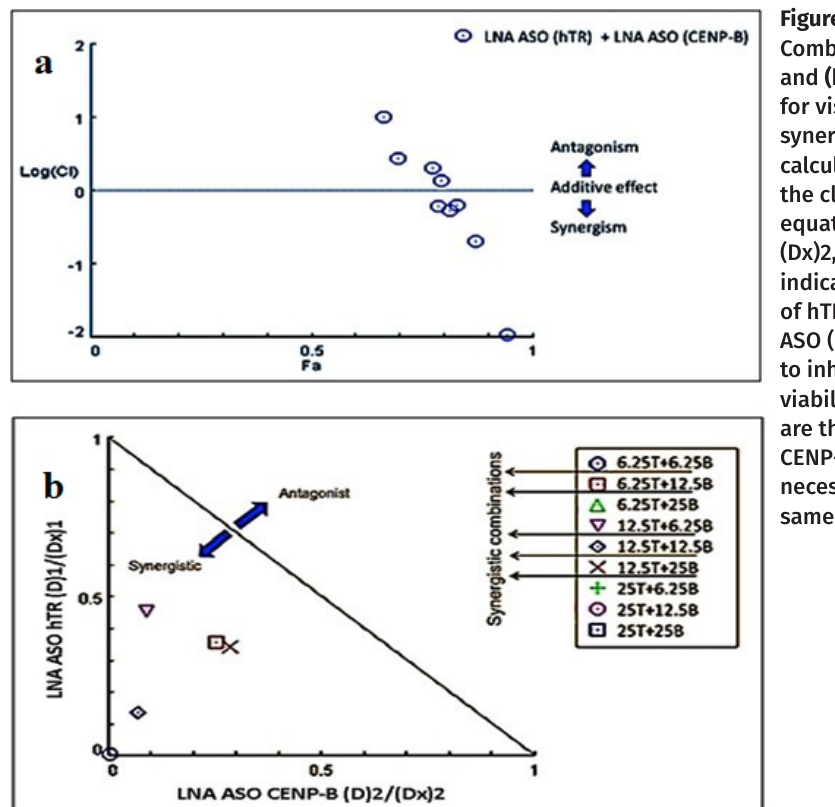
Figure 3. (a) Logarithmic Combination Index Plot and (b) Isobologram are for visual determination of synergism or antagonism calculated according to the classic isobologram equation: CI=(D)1/(Dx)1+(D)2/ (Dx)2, where (Dx)1 and (Dx)2 indicates the individual dose of hTR ASO (T) and CENP-B ASO (B); respectively, required to inhibit the given level of viability index. (D)1 and (D)2 are the doses of hTR ASO and CENP-B ASO; respectively, necessary to produce the same effect in